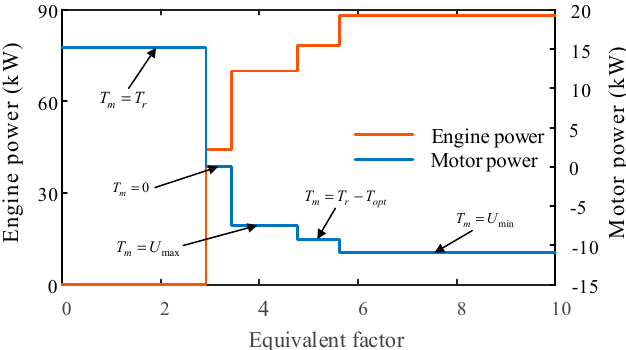
Figure 3. The optimal power varying with the equivalence factor.